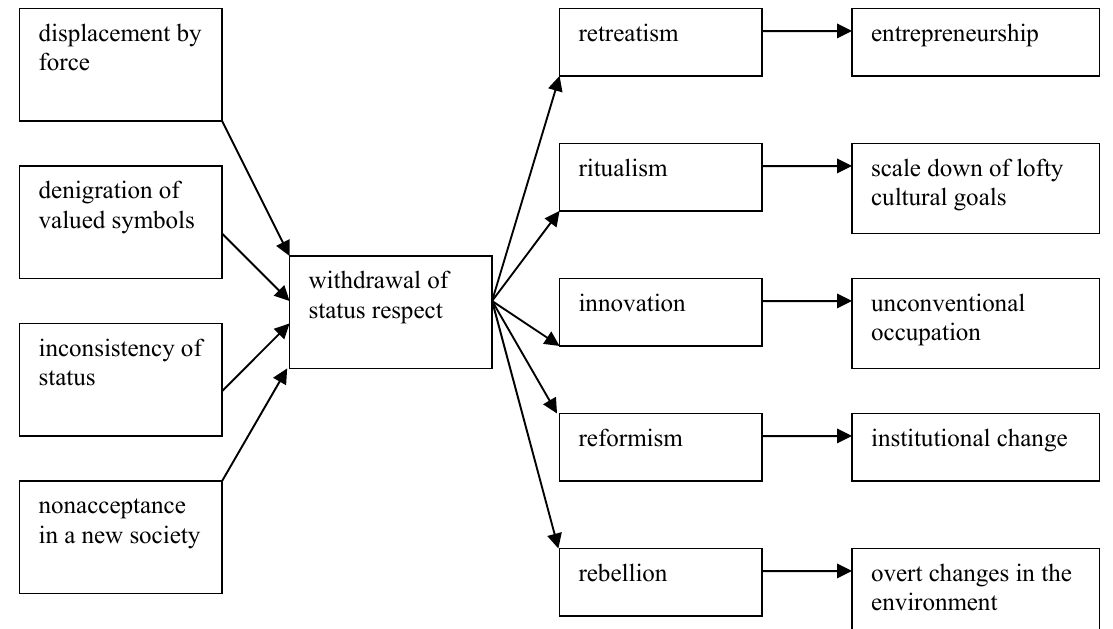
Figure 2: Diagram showing the relationship of variables in Hagen’s withdrawal of status